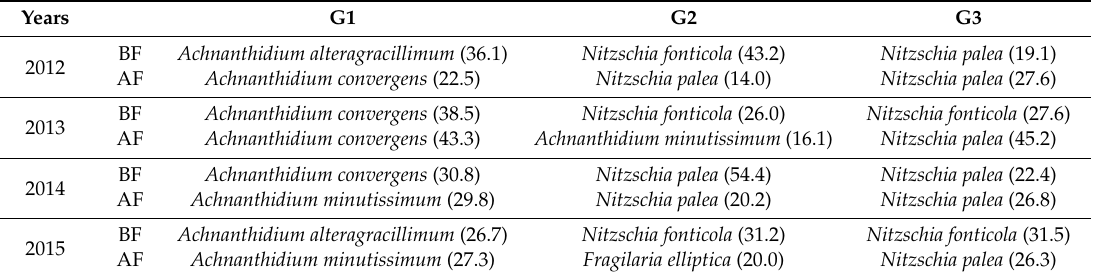
Table 2. The dominant species and their relative abundances (%) in each diatom community (G1–3), before (1st) and after (2nd) the monsoon in the Hantangang River from 2012 to